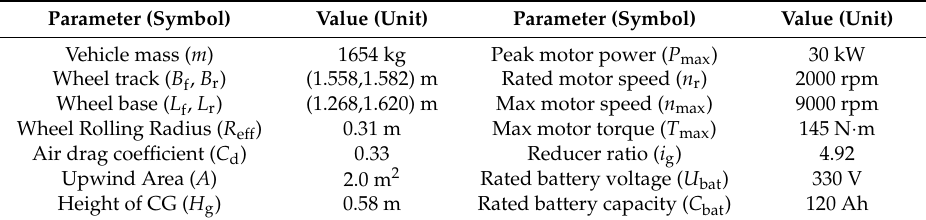
Table 3. Recommended parameters of the estimation algorithm.